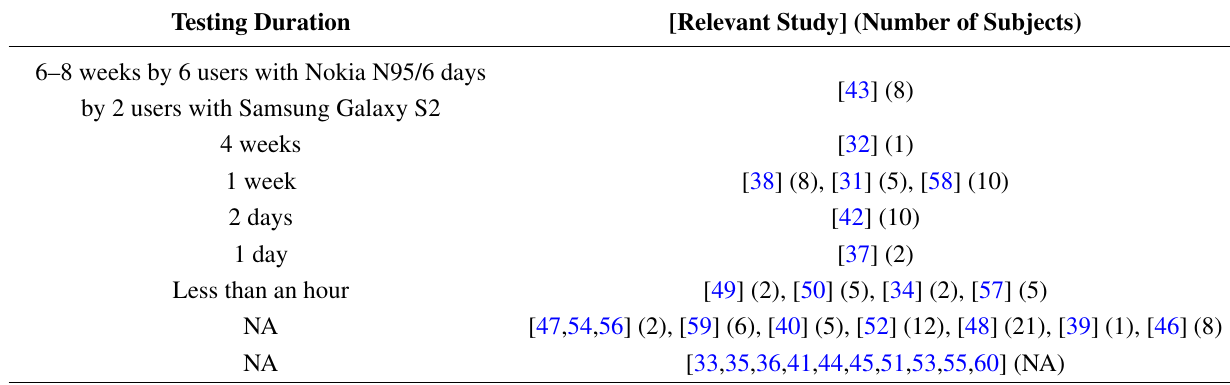
Table 10. Evaluation of online activity recognition